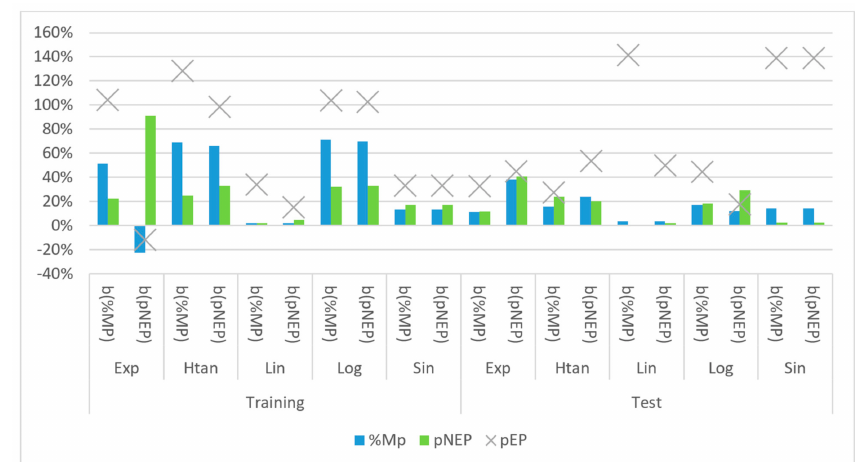
Figure 4. The highest values of the %MP and pNEP indicators, broken down by the type of activation function in the hidden layer, from the perspective of the training set.